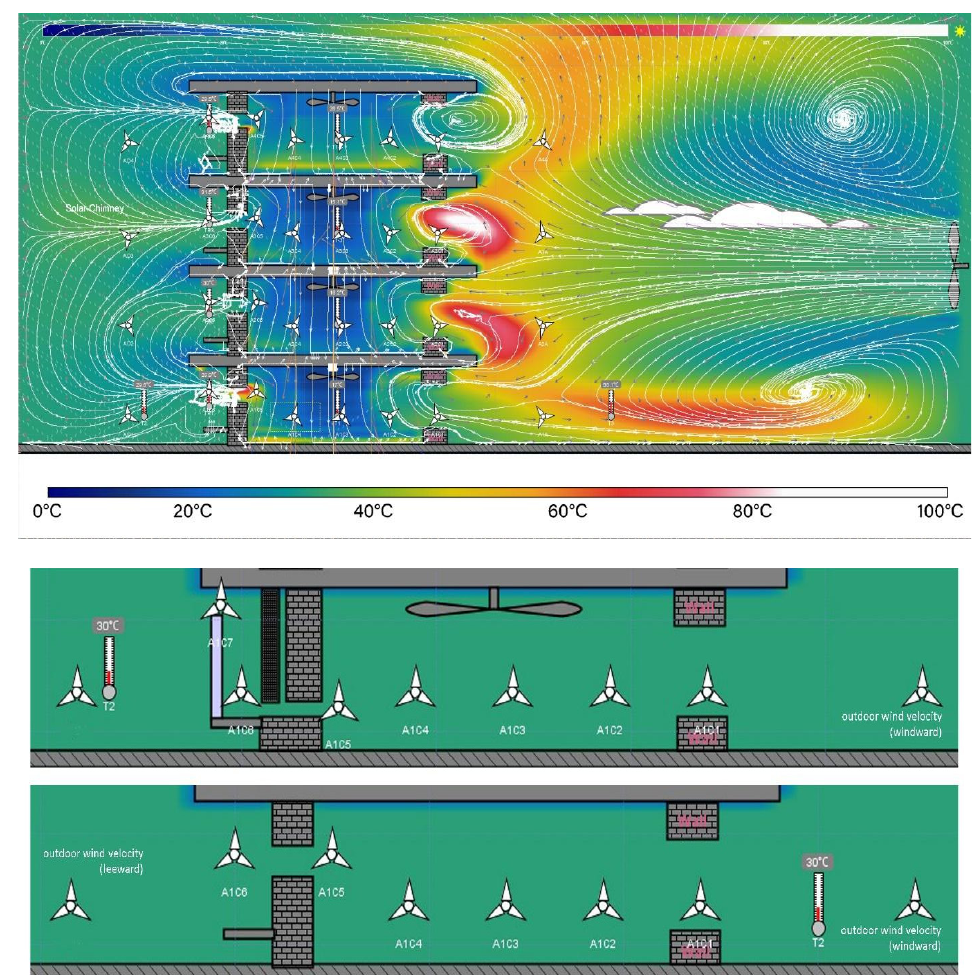
Figure 9. Locations of wind velocity sensors in each simulation model, with SC ( middle ) and without SC ( below